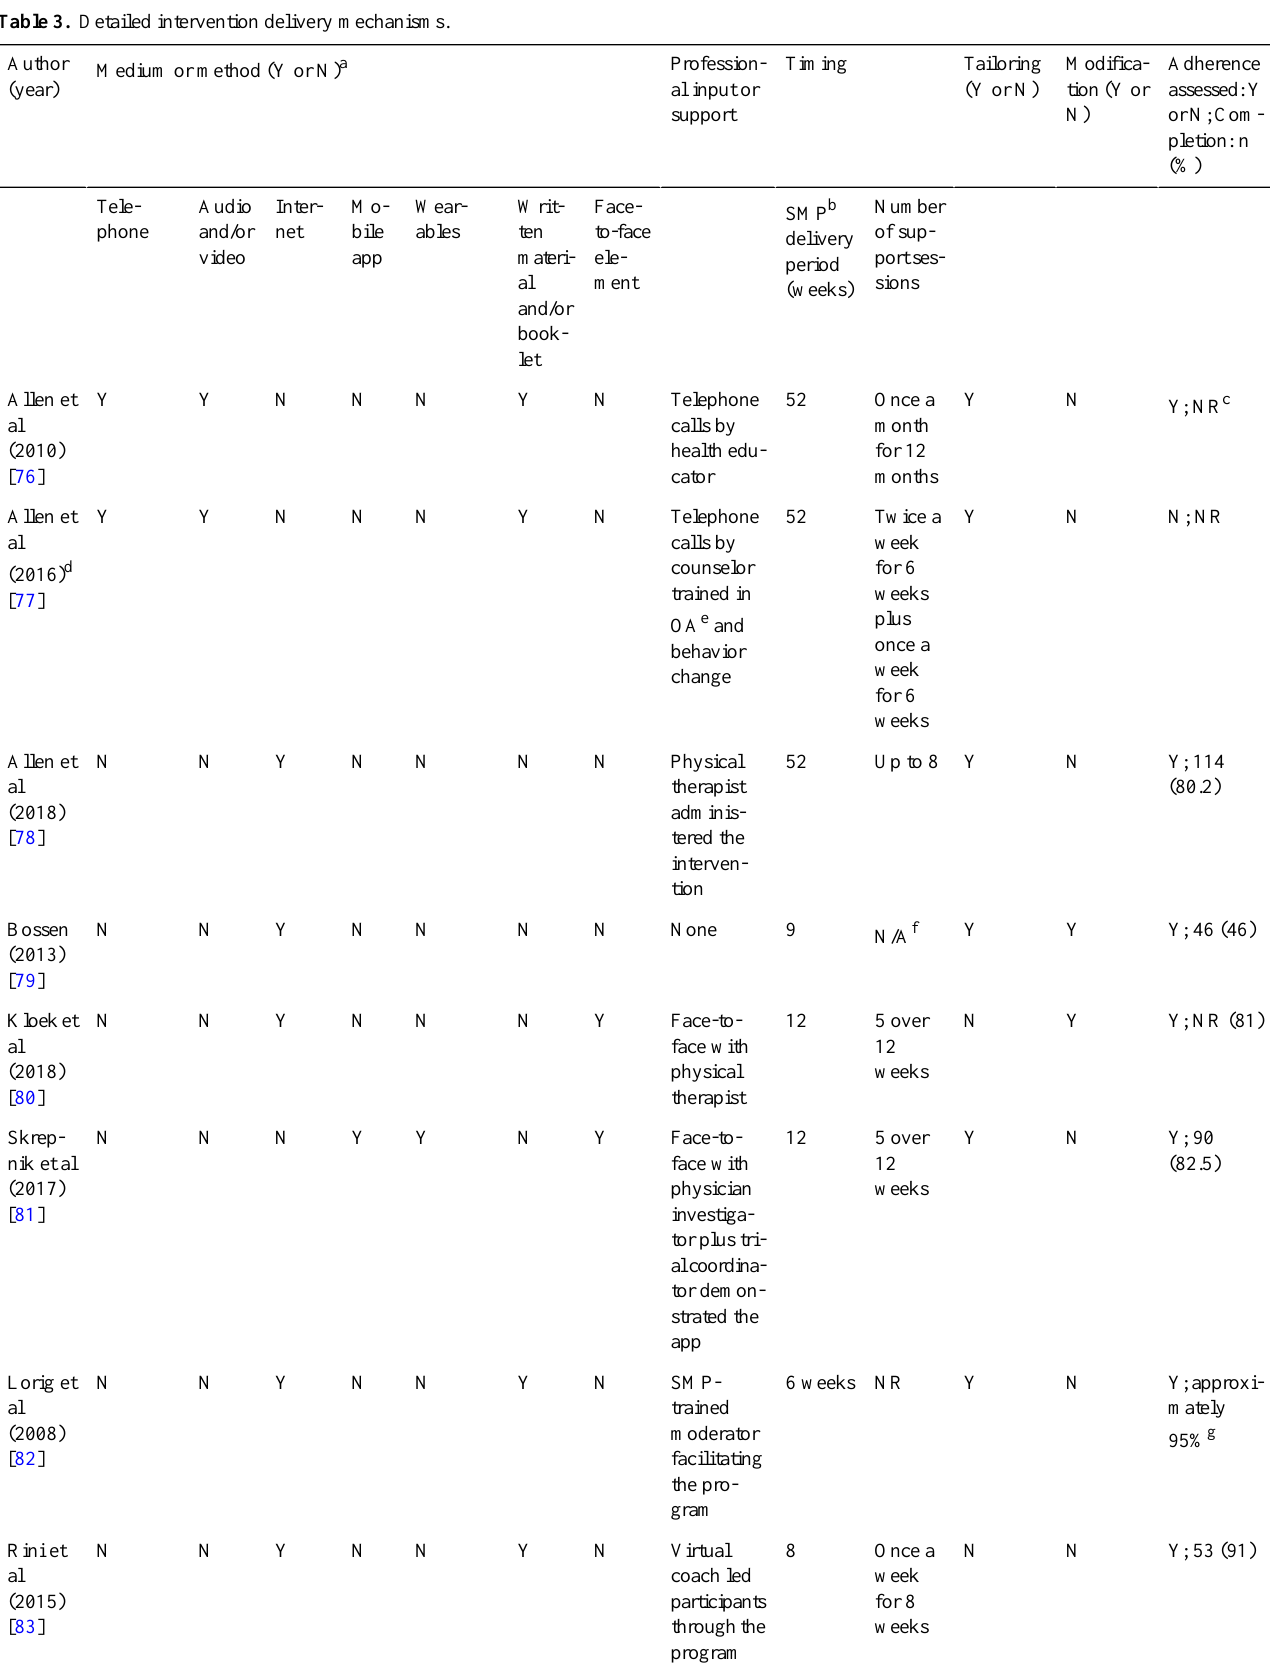
Table 3. Detailed intervention delivery mechanisms.